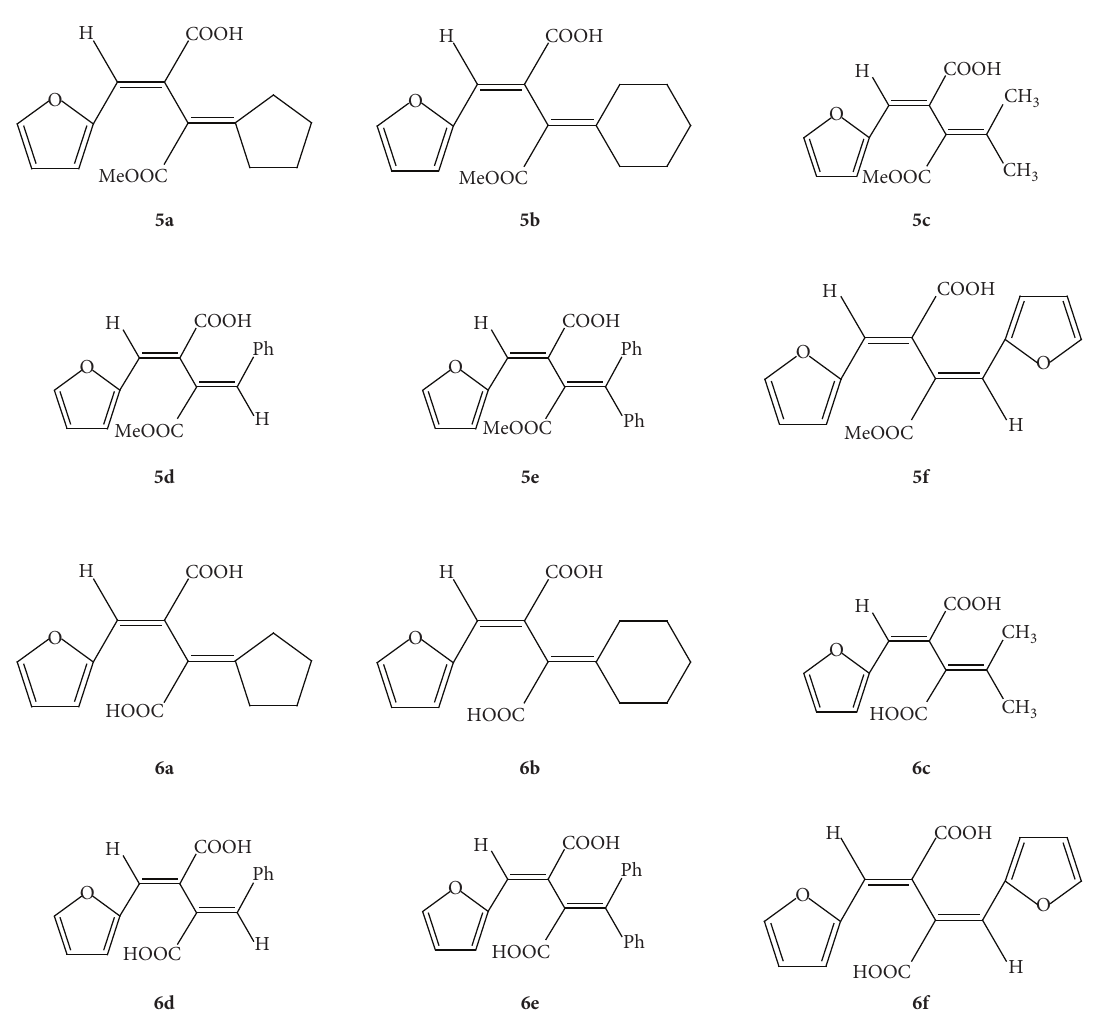
F 1: Stobbe products 5a–f and diacids 6a–f .